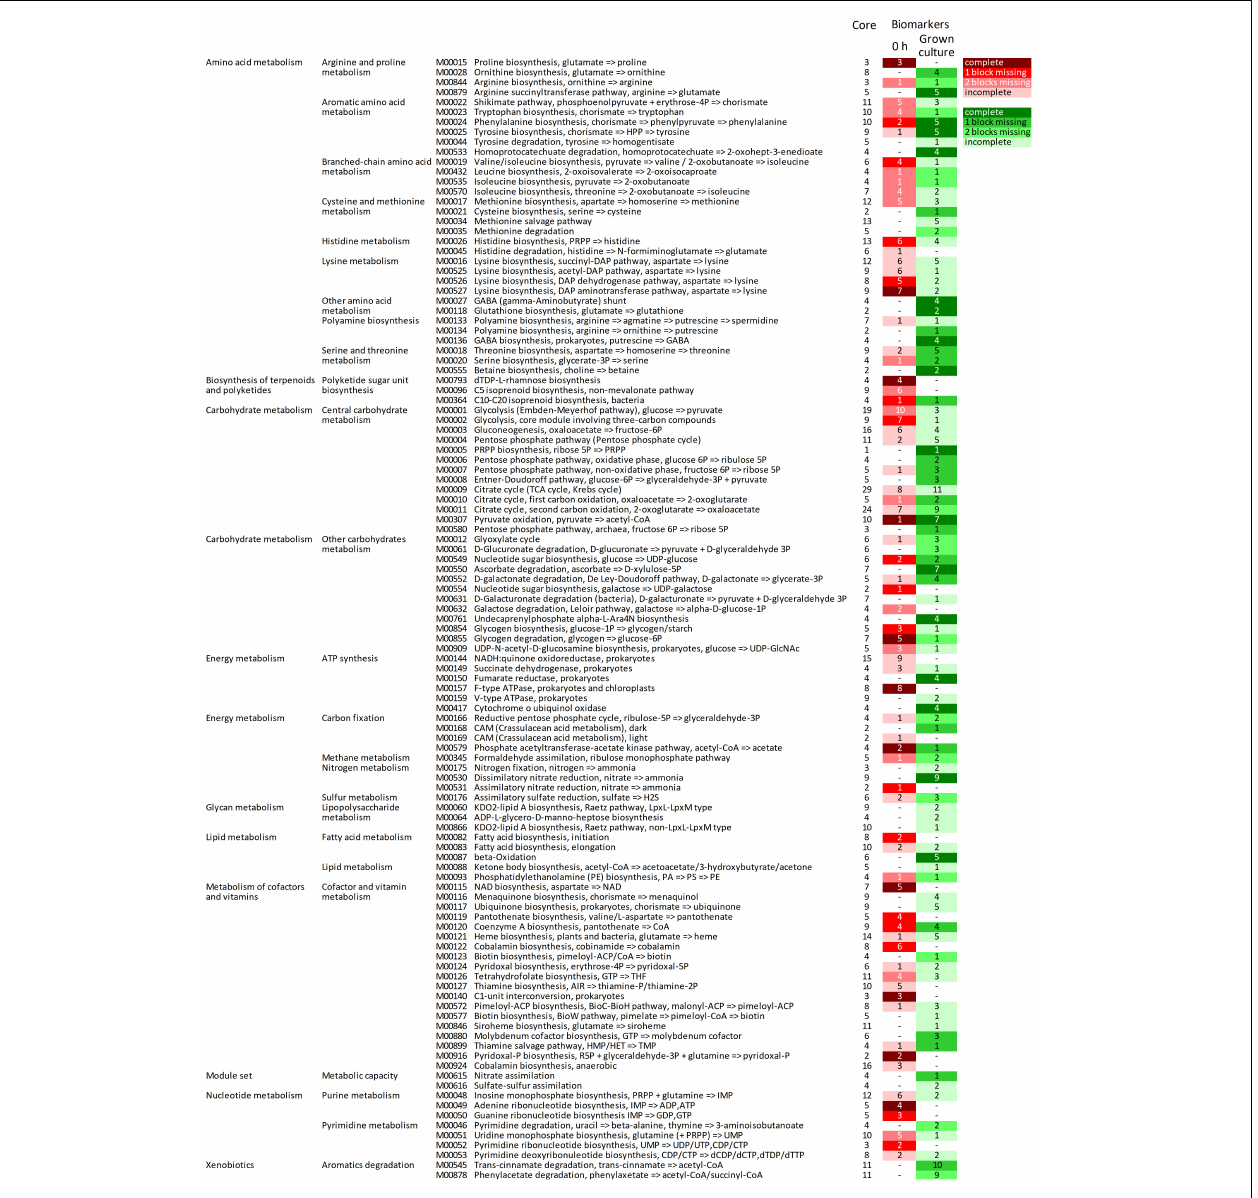
FIGURE 5 | Complete metabolic modules predicted in the core metagenome at 0 h presenting statistically significant differential abundance between 0 h and grown cultures (6 or 12 h). For each module, the total number of KOs recognized by KEGG’s mapper and the number of biomarker KOs characterizing cultures at 0 h (red shades) and grown cultures (green shades), according to LEfSe, are reported. Red and green shades from the darkest to the lightest indicate the degree of completeness of the module changing in abundance (complete, 1 block missing, 2 blocks missing, and > 2 blocks missing); “–” indicates non-significant changes. KEGG, Kyoto Encyclopedia of Genes and Genomes; KO, KEGG